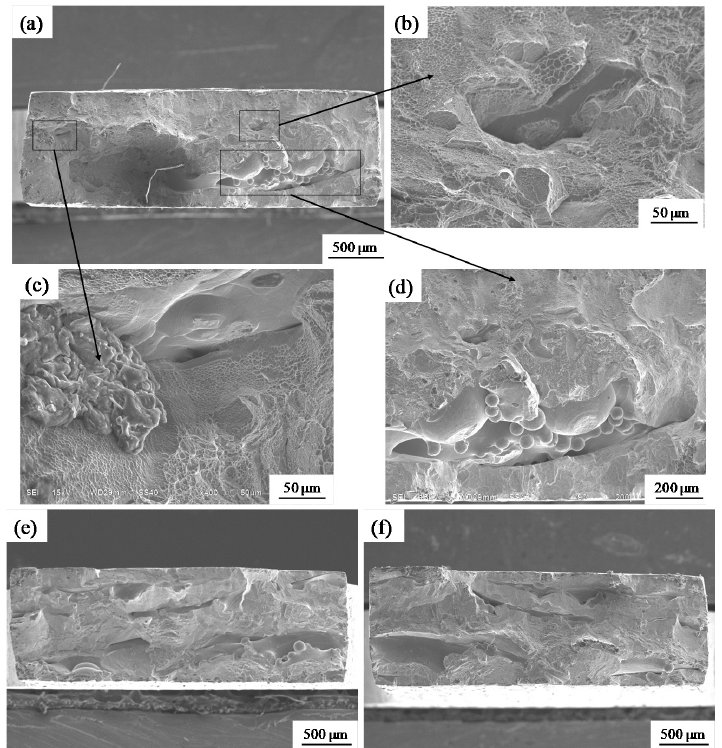
Figure 13. Scanning electron micrographs of tensile fracture surfaces of SLM-produced specimens. ( a ) Overall view of the tensile specimen ( Φ D = 50 µm, v = 75 mm/s); ( b – d ) Magnified views of the boxed region in image ( a ); ( e ) Overall view of the tensile specimen ( Φ D = 200 µm, v = 75 mm/s); ( f ) Overall view of the tensile specimen ( Φ D = 200 µm, v = 100 mm/s).